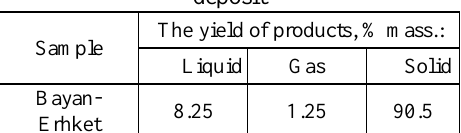
Table 5. The yield of liquid products obtained by heat treatment of bituminous sand of the